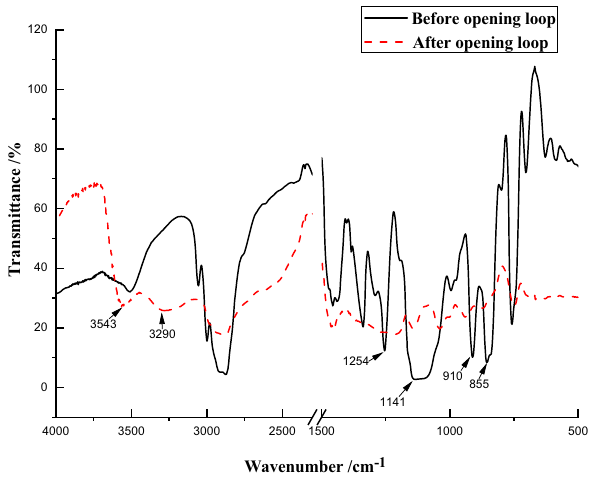
Figure 2: Infrared spectrum of